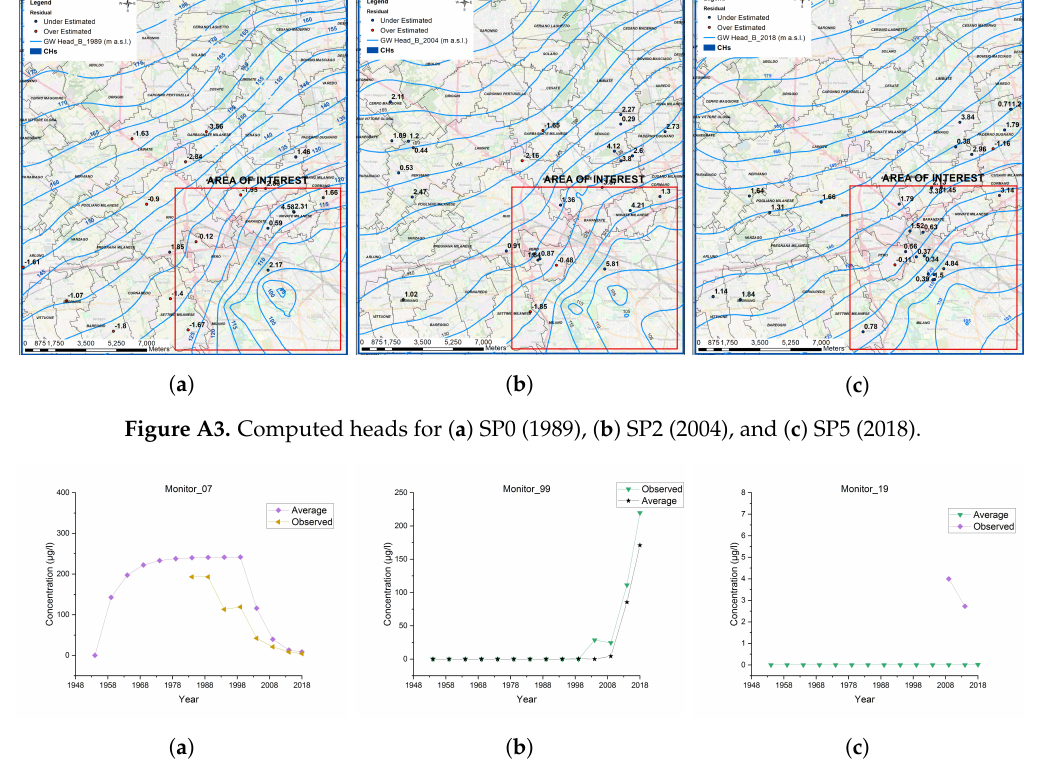
Figure A4. Comparison between measured and computed concentrations (B-T curves) for Monitoring Wells ( a ) Monitor_07, ( b ) Monitor_99, and ( c ) Monitor_19. The computed value is given by the average value simulated in the layer actually screened by the